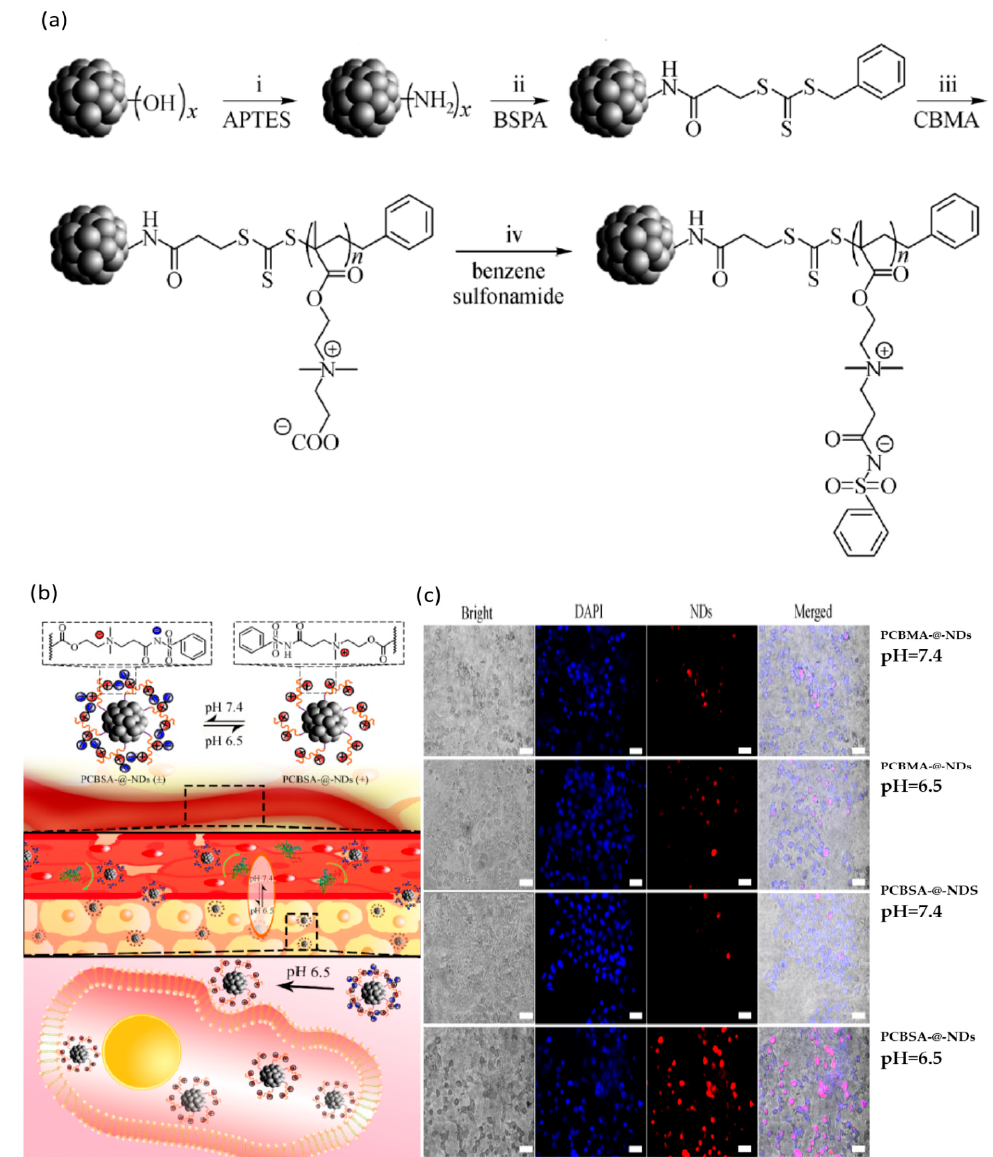
Figure 6. ( a ) Illustration of synthesis of PCBSA ‐ @ ‐ nanodiamonds (NDs): 3 ‐ Amin ‐ opropyltriethoxysilane (APTES) (i); 3(((benzylthio)carbonothioyl)thio)propanoic acid (BSPA) (ii); carboxybetaine methacrylate (CBMA) (iii); benzene sulfon ‐ amide (iv). ( b ) Schematic representation of the PCBSA ‐ @ ‐ NDs’ performance at surface conversional charge and tumor cell uptake; ( c ) images of fluorescence microscopy for HepG2 treated with PCBMA ‐ @ ‐ NDs at different pH values (scale is 50 μ m). Reproduced from [82], with permission from © Higher Education Press 2020.